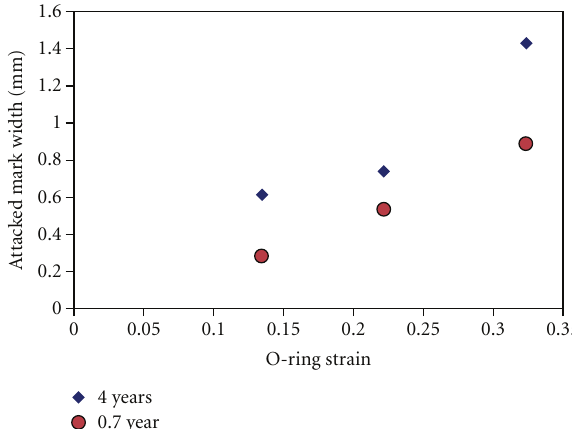
Figure 5: Crevice width of stainless steel samples fitted with O-rings of varying